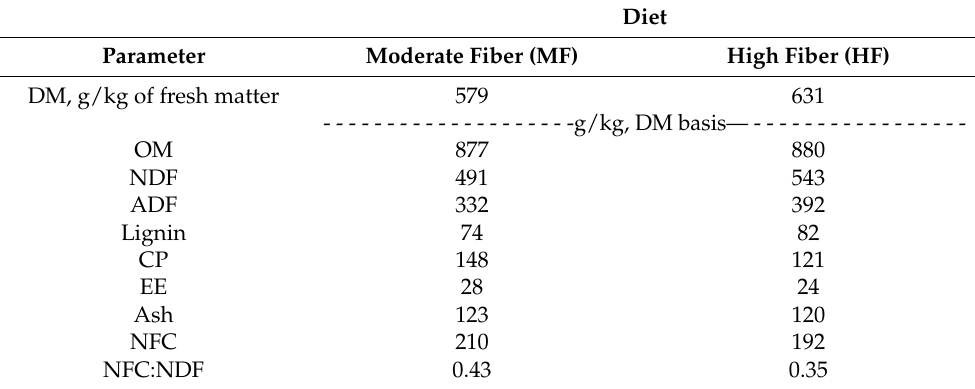
Table 1. Chemical composition of forage diets with moderate fiber content (MF) and high fiber content